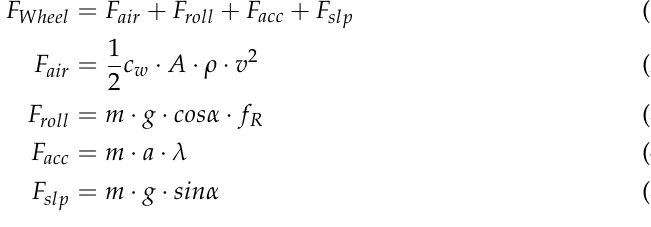
Table 4. Parameters and units of the shown driving resistance equations. Description Symbol Unit Drag coefficient c w - Projected frontal